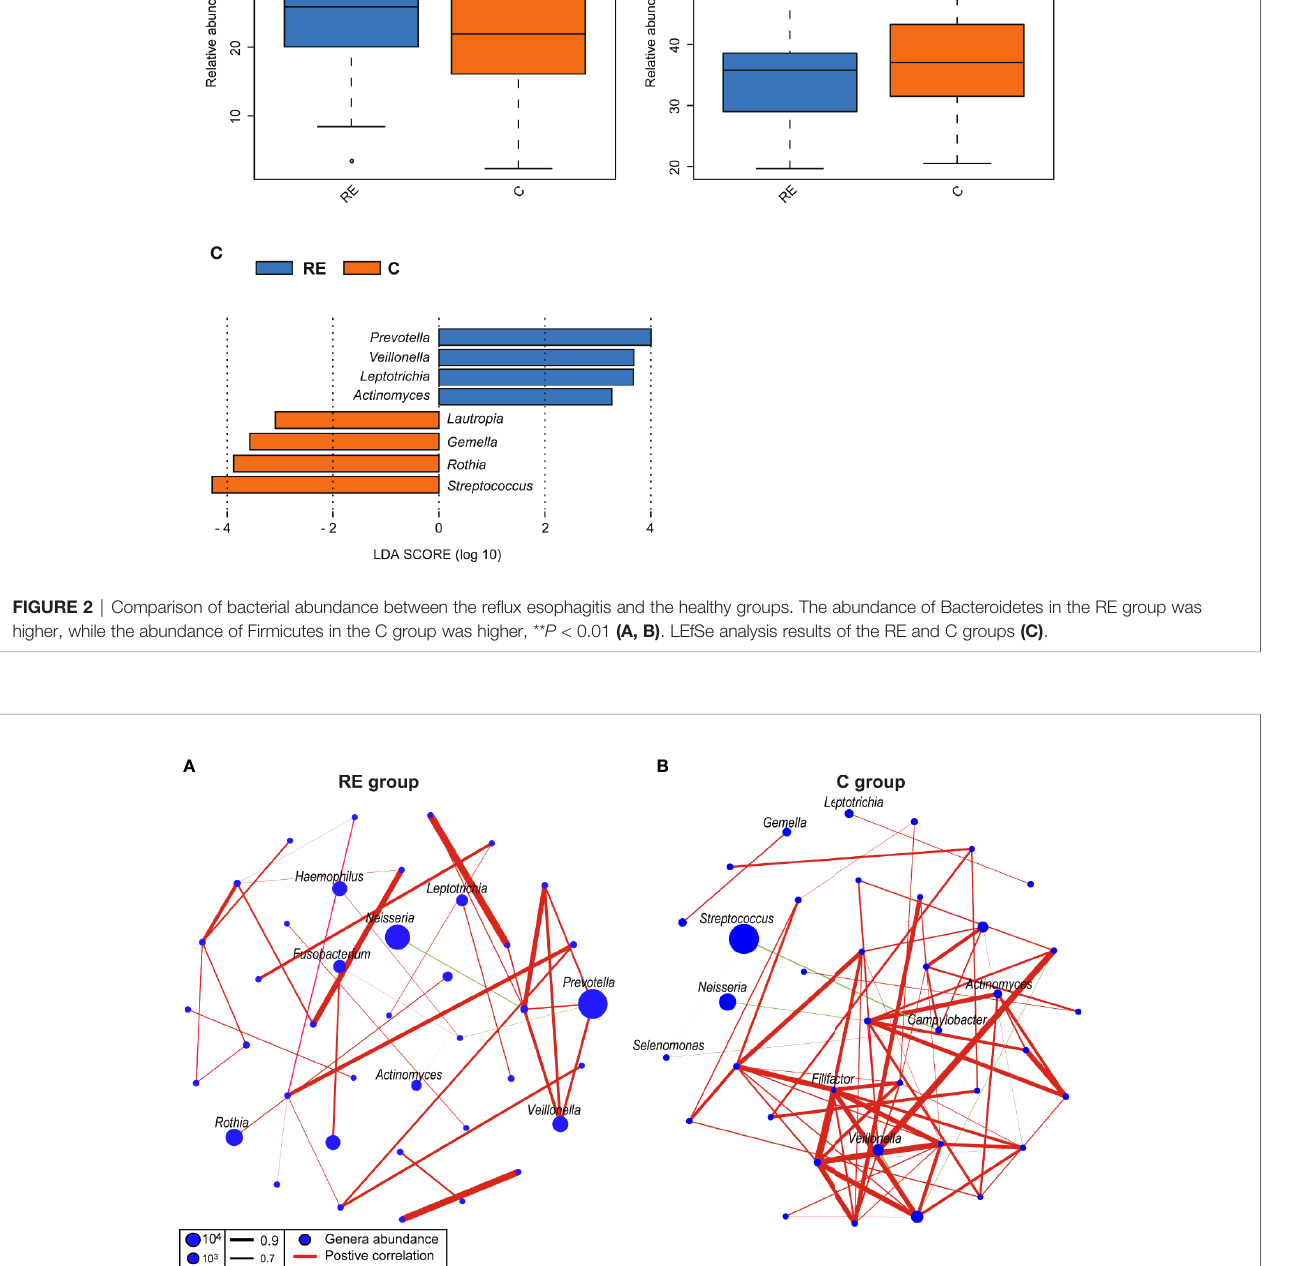
FIGURE 3 | Co-occurrence networks of the re fl ux esophagitis and healthy groups (A, B) . The co-occurrence network was inferred by the pairwise correlation of the relative abundances of all genera. Each node in the network represents a bacterial genus. The node size represents the mean relative abundance of a genus in the oral microbiota. Red line: positive correlation; green line: negative correlation. Relative thickness of the lines represents the degree of the correlation (greater thickness of the edges means a stronger